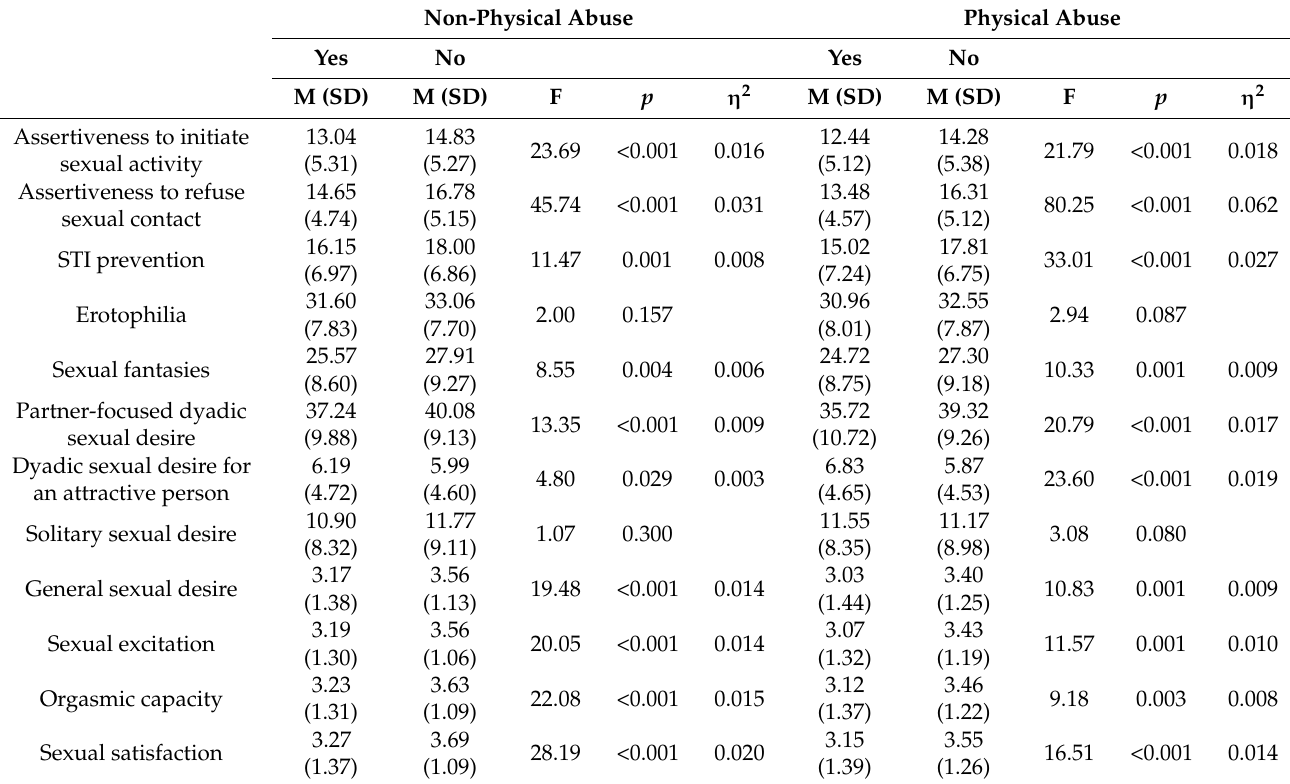
Table 3. Differences of each type of abuse on the sexual health variables controlling covariates in women. Non-Physical